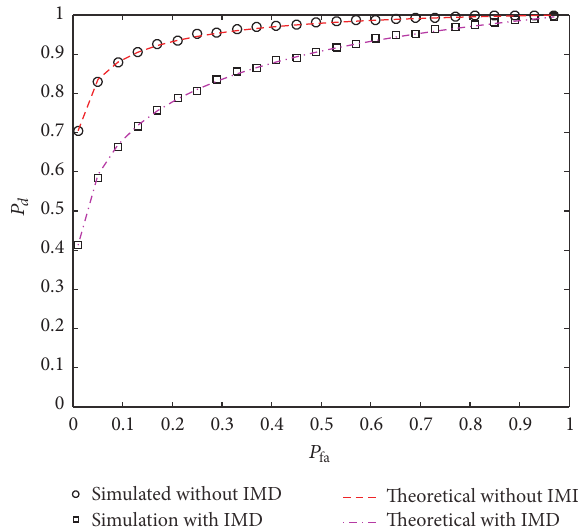
Theoretical without IMD